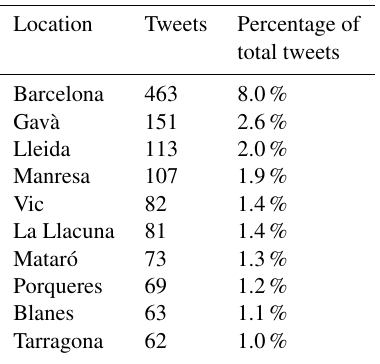
Table 1. Locations with a higher share of the total number of tweets.